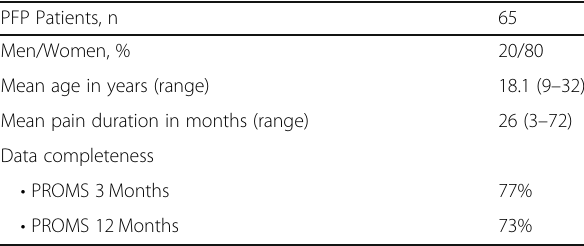
Table 1 Patients demography PFP Patients,